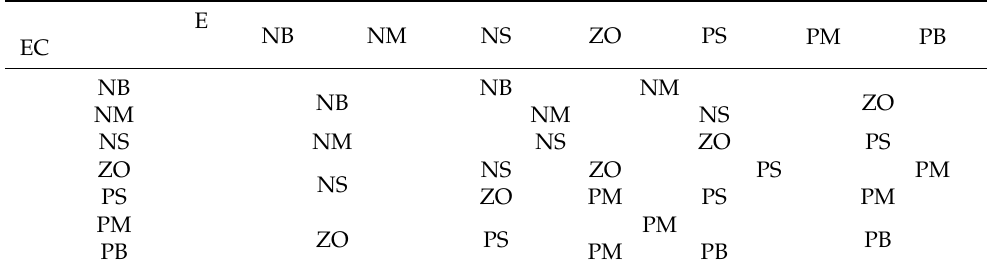
Table 2. ∆ K i fuzzy rule